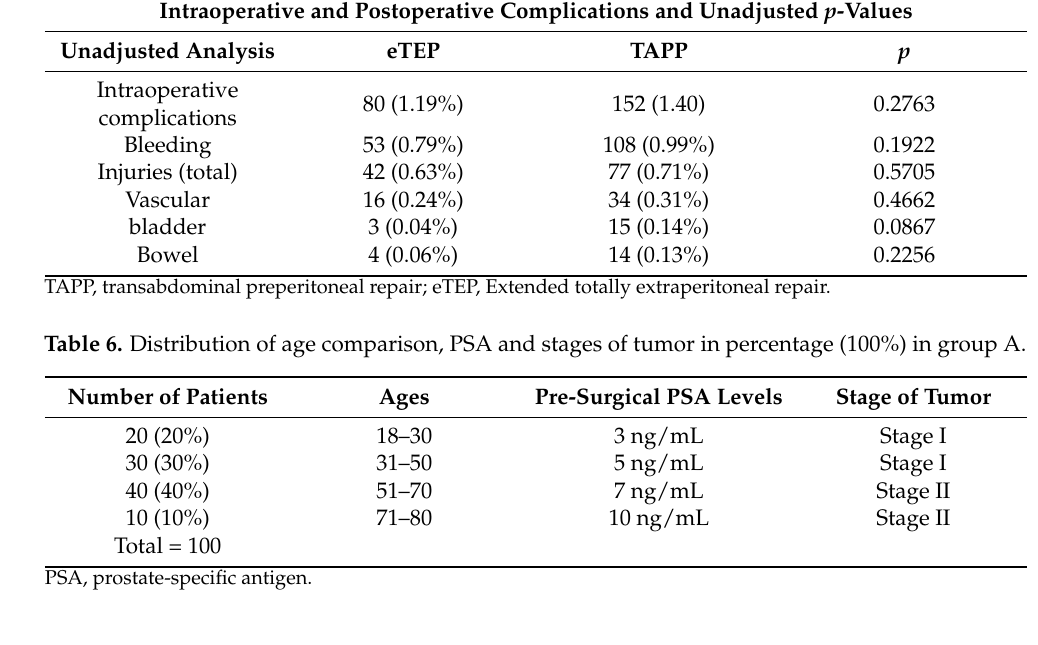
Table 5. Intraoperative and postoperative complications and unadjusted p -values.